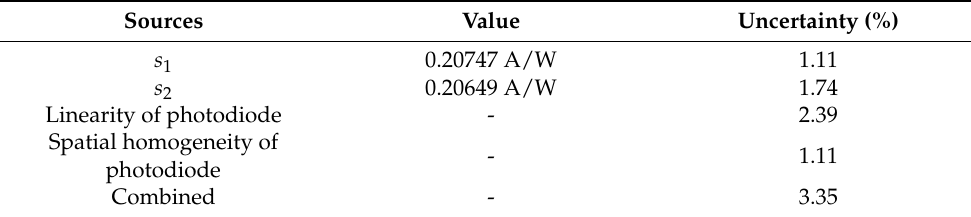
Table 4. Uncertainty of the comparison experiment ( k =